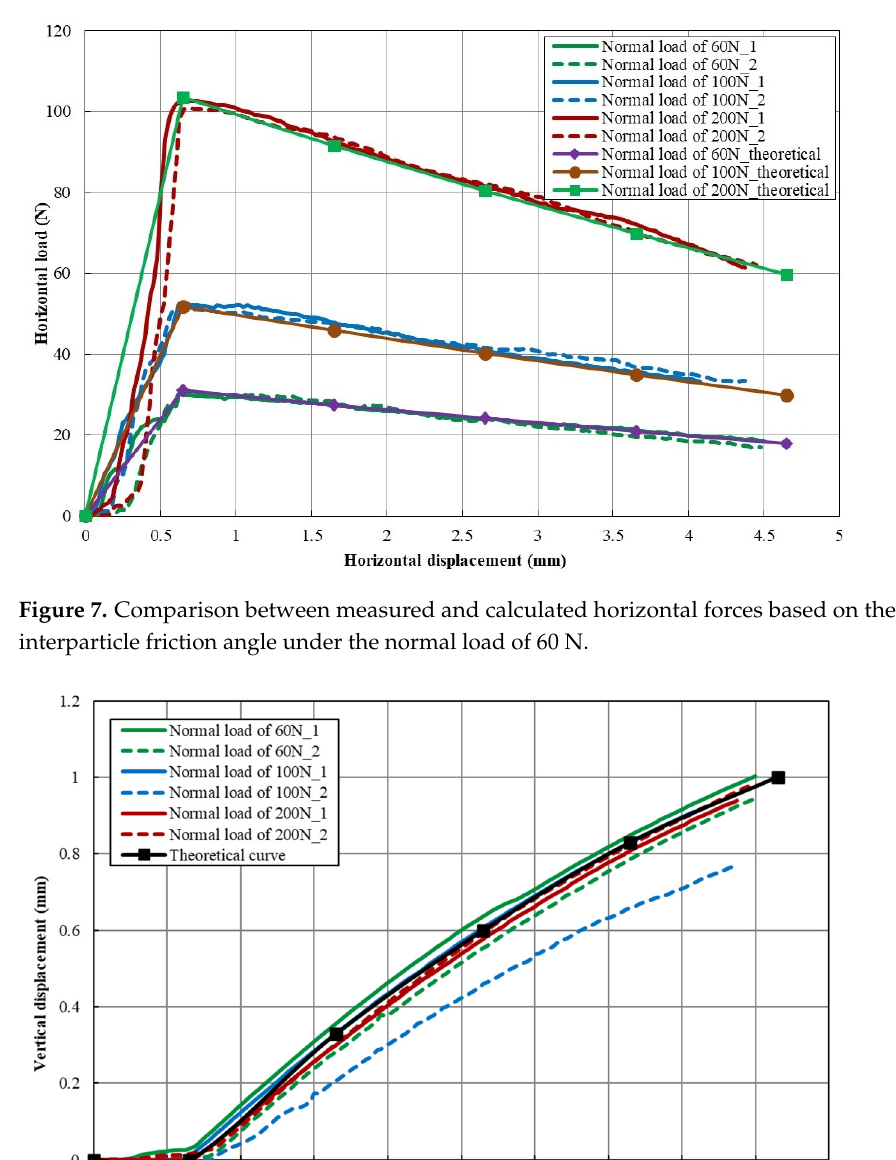
Figure 7. Comparison between measured and calculated horizontal forces based on the measured interparticle friction angle under the normal load of 60 N.